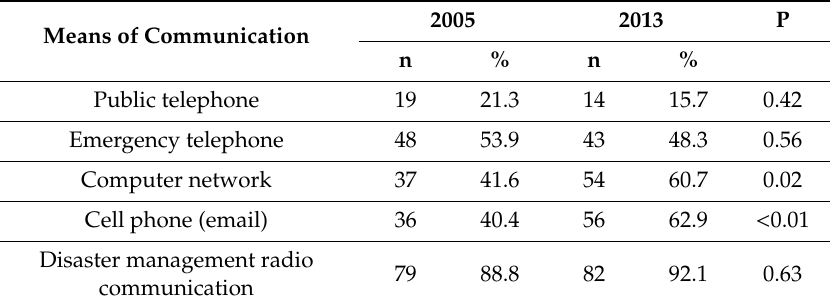
Table 2. Changes in means of communications shown in local disaster management plans, guidelines, or manuals before and after the Great East Japan